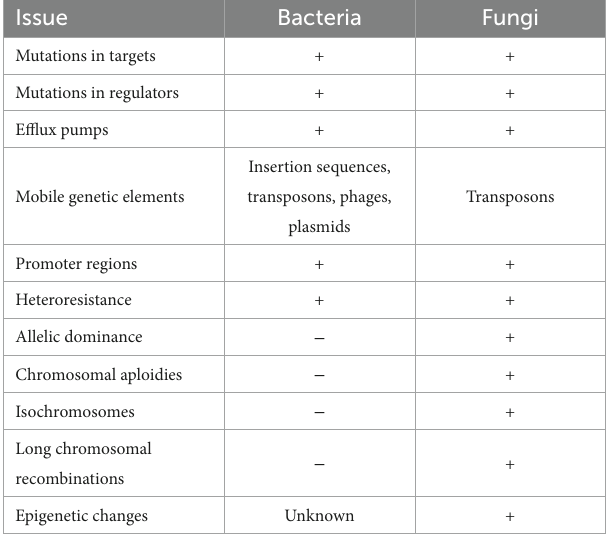
TABLE 1 Antimicrobial resistance issues for bacterial and fungal